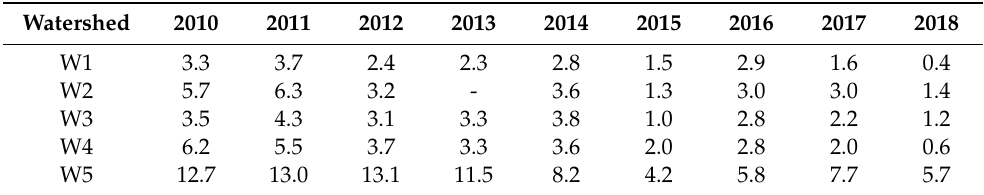
Table 3. Suspended sediment concentration (g L − 1 ) for the main watershed W5 and the nested watersheds